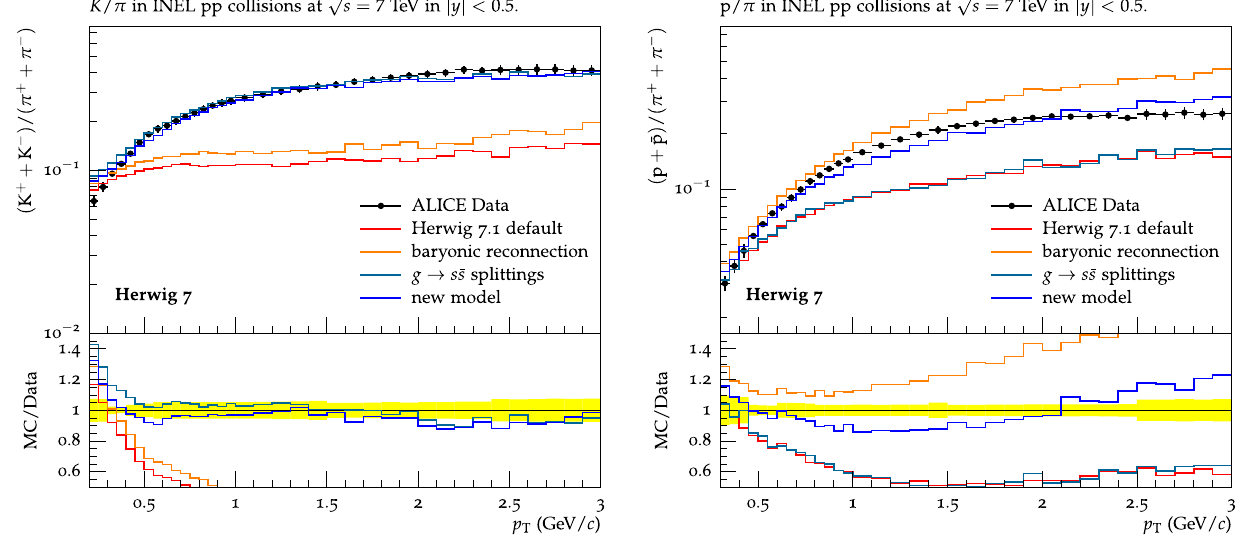
√ s = 7TeV [25] in the very central rapidity region